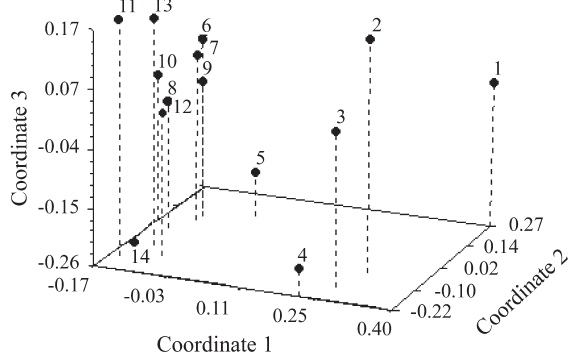
Figure2 -Principalcoordinateanalysisofgeneticdistanceamong14elite C. arabica cultivars. The first, the second, and the third principal coordi-